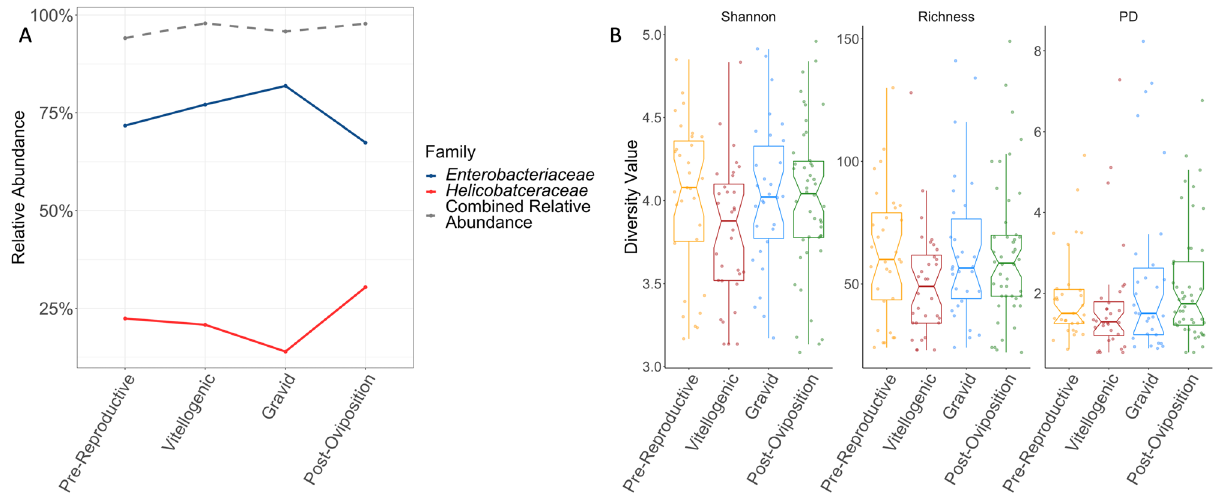
Figure 6. ( A ) Mean relative abundance of Enterobacteriaceae and Helicobacteraceae in cloacal microbiomes of female S. virgatus across four reproductive stages, as well as the total combined relative abundance of these two families. ( B ) Diversity (Shannon index), richness, and Faith’s phylogenetic diversity (PD) of cloacal microbiomes for female S. virgatu s across reproductive state. Boxes represent median and quartiles, while whiskers indicate 95% confidence